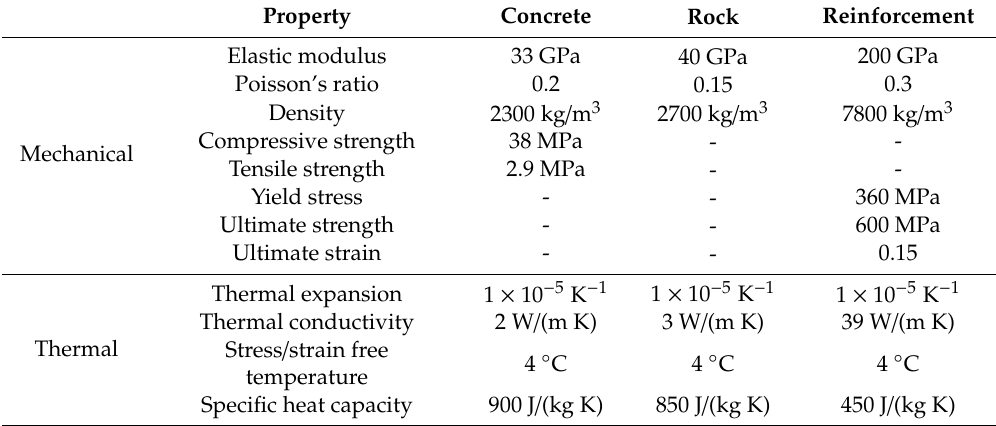
Table 2. Material properties as given by